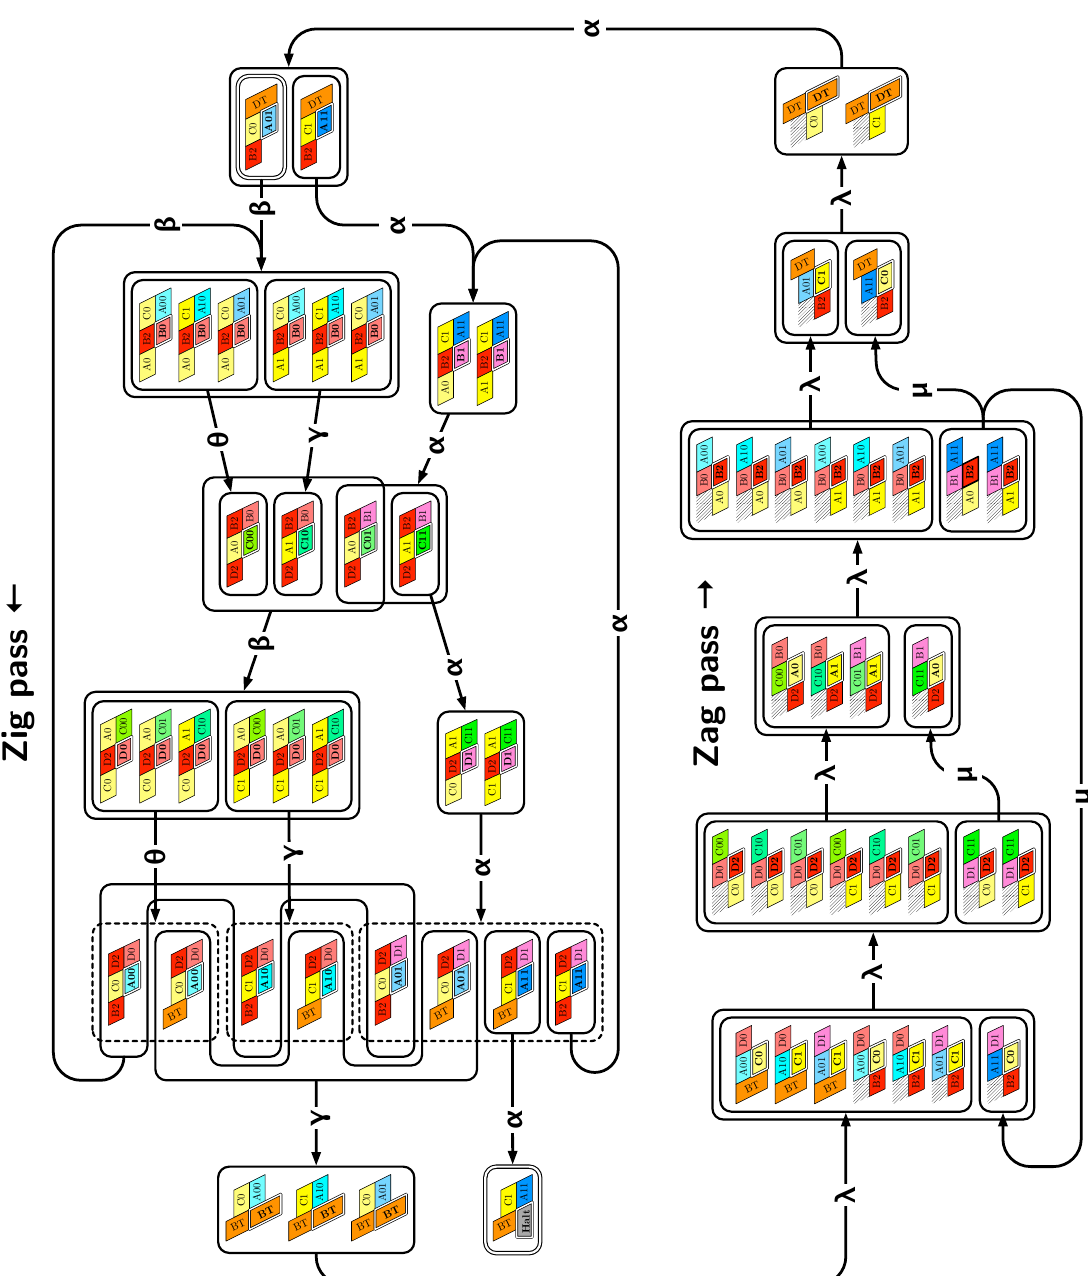
Figure 18. The brick automaton illustrating how Lemmas 1–10 (Supplementary Materials) work together to prove Theorem 1 by